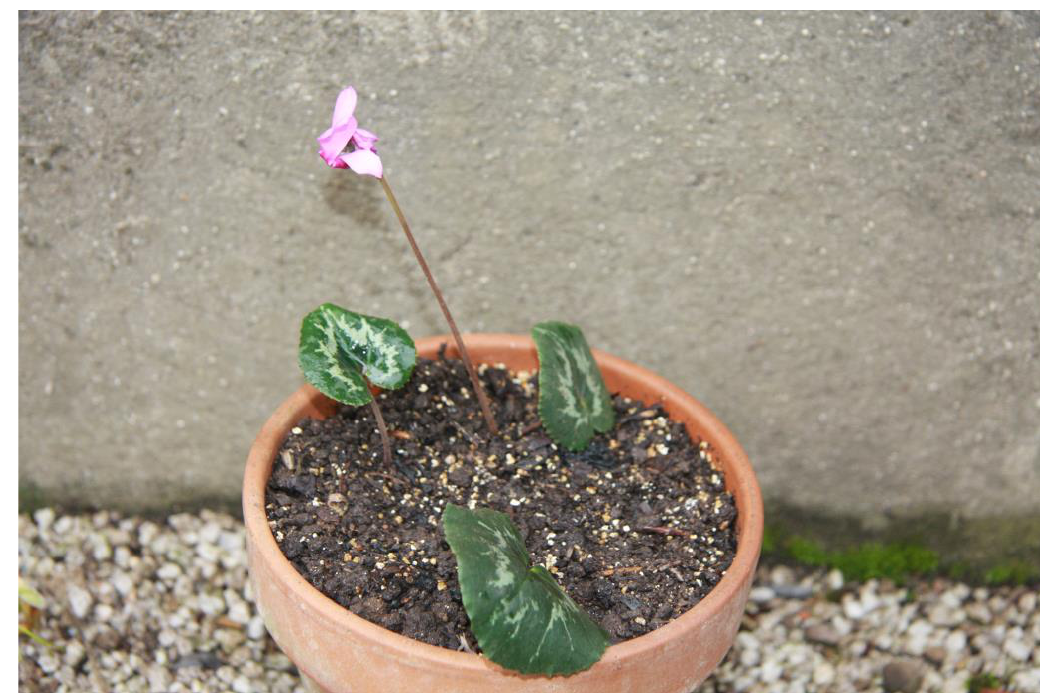
Figure 13. C. purpurascens ‘Slivje’.